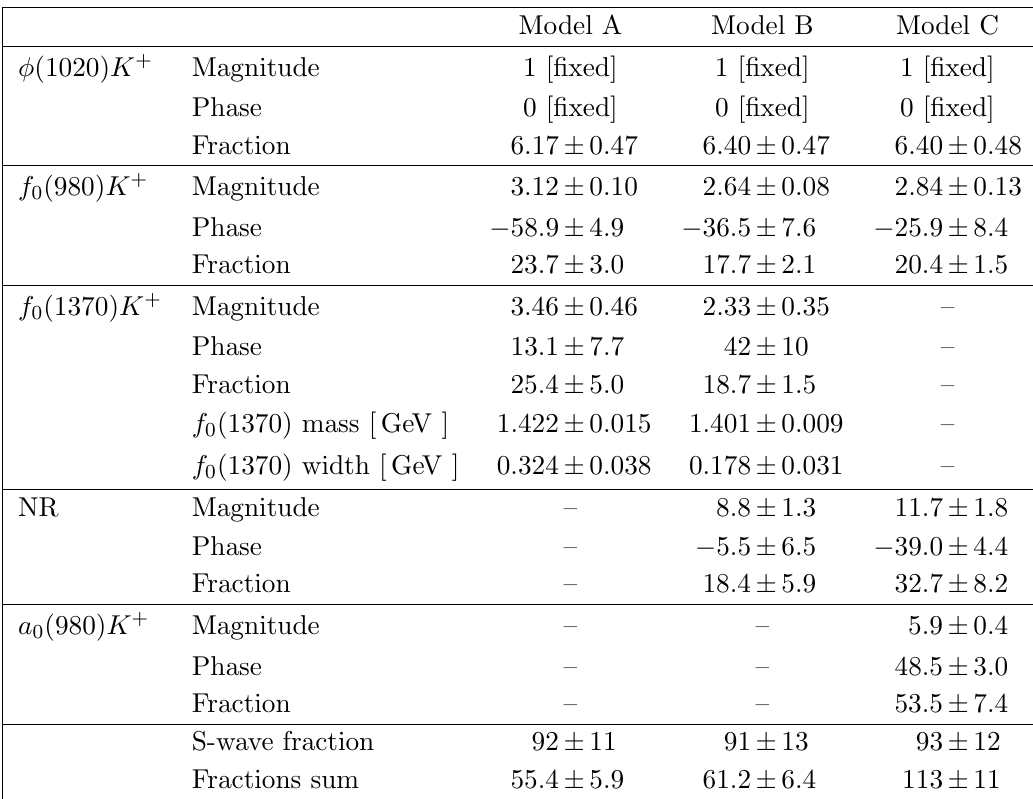
Table 1 . Results from the D + ! K (cid:0) K + K + Dalitz plot (cid:12)t with the isobar models A, B and C. Magnitudes, j c k j , phases, arg( c k ) (in degrees), and (cid:12)t fractions (in %) are given with statistical uncertainties